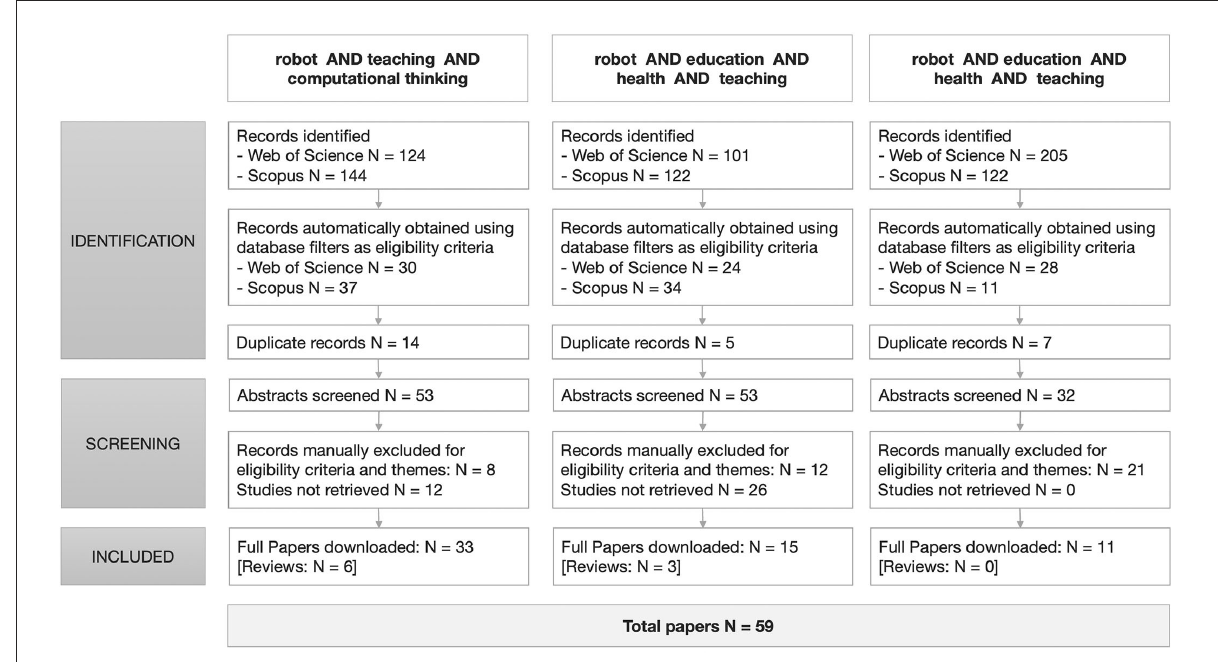
FIGURE1 Process of scoping review related to the three strings about ER: (1) teaching and computational thinking, (2) training in the health sector, and (3) education and special